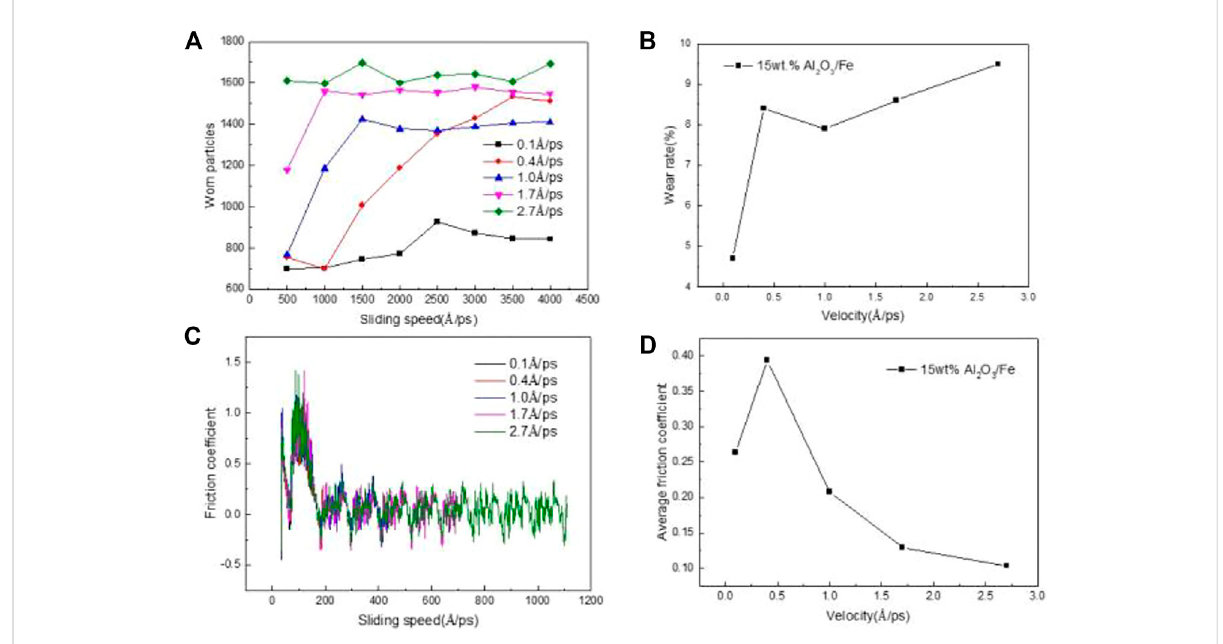
FIGURE 9 (A) Variation of worn particles with sliding distance in 15 wt% Al 2 O 3 /Fe amorphous composite model; (B) variation of wear rate with different speeds in 15 wt% Al 2 O 3 /Fe amorphous composite model; (C) variation of friction coef fi cient with sliding distance in 15 wt% Al 2 O 3 /Fe amorphous composite model; (D) variation of average friction coef fi cient with different speeds in 15 wt% Al 2 O 3 /Fe amorphous composite